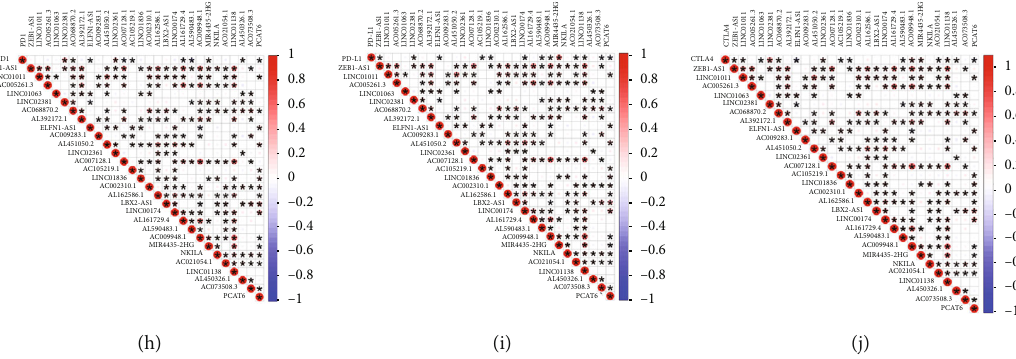
Figure 3: Distinct immune cell in fi ltration in two clusters and association of immune checkpoint inhibitors in colon cancer. (a) In fi ltration levels of 22 immune cell types in clusters 1 and 2, (b) immunoscores in clusters 1 and 2, (c) stromal scores in clusters 1 and 2, (d) estimated scores in clusters 1 and 2, (e) PD1 expression levels in clusters 1 and 2, (f) PDL1 expression levels in clusters 1 and 2, (g) CTLA4 expression levels in clusters 1 and 2, (h) correlation between PD1 expression level and di ff erential expression of ferroptosis-related lncRNAs, (i) correlation between PDL1 expression level and di ff erential expression of ferroptosis-related lncRNAs, and (j) correlation between CTLA4 expression level and di ff erential expression of ferroptosis-related lncRNAs, ∗∗ p < 0 : 01 and ∗∗∗ p < 0 : 001